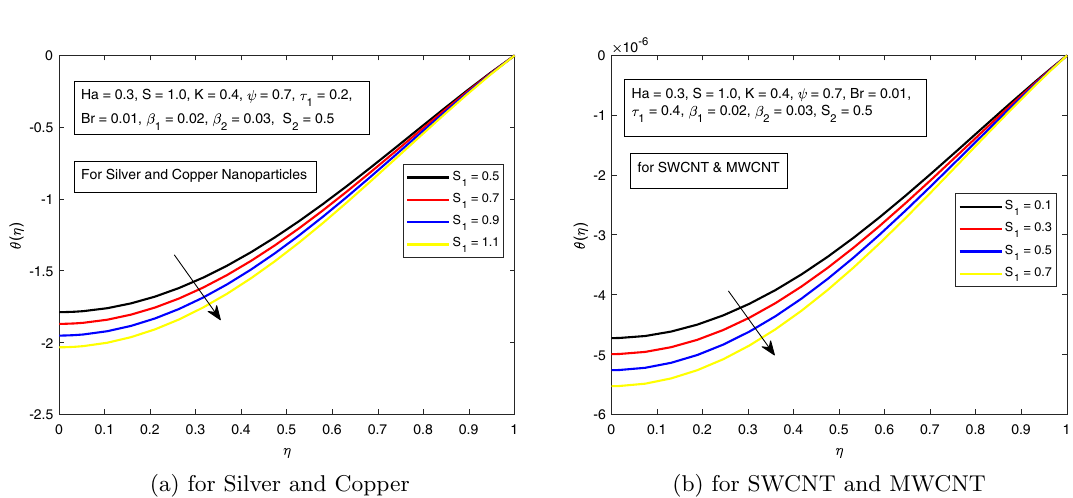
Figure 8. Influence of S 1 on temperature distribution θ( r ) for the hybrid nanofluid combination of ( a ). Ag and Cu , ( b ) SWCNT and MWCNT